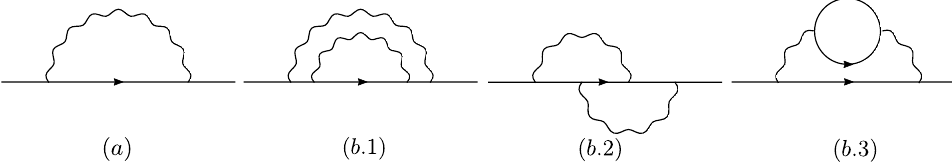
Figure 7 . Feynman rules for the zero-momentum insertions of the composite operators. Note that there are two vertices associated to O 2 .